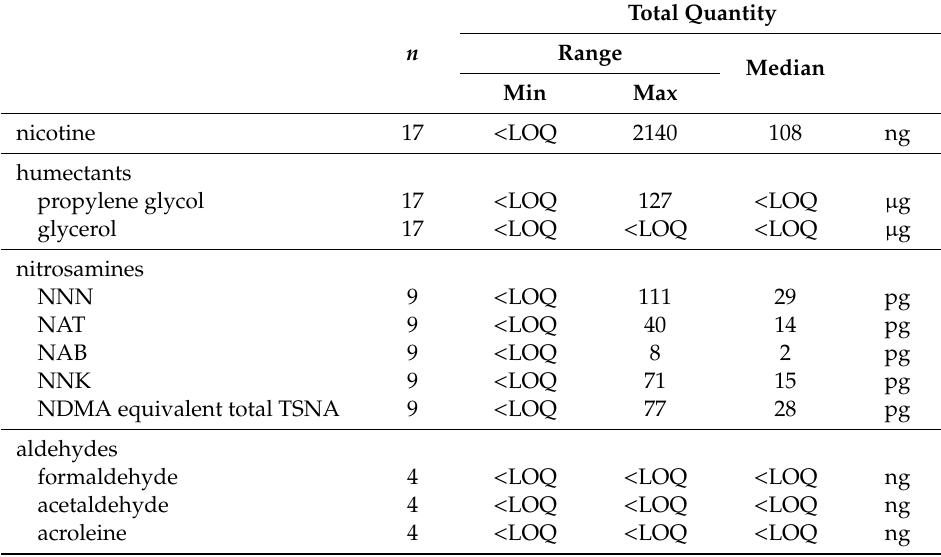
Table 3. Chemical analysis of exhaled vapor. The column ‘total quantity’ lists average amounts recovered in the first exhaled breath after inhaling a pu ff